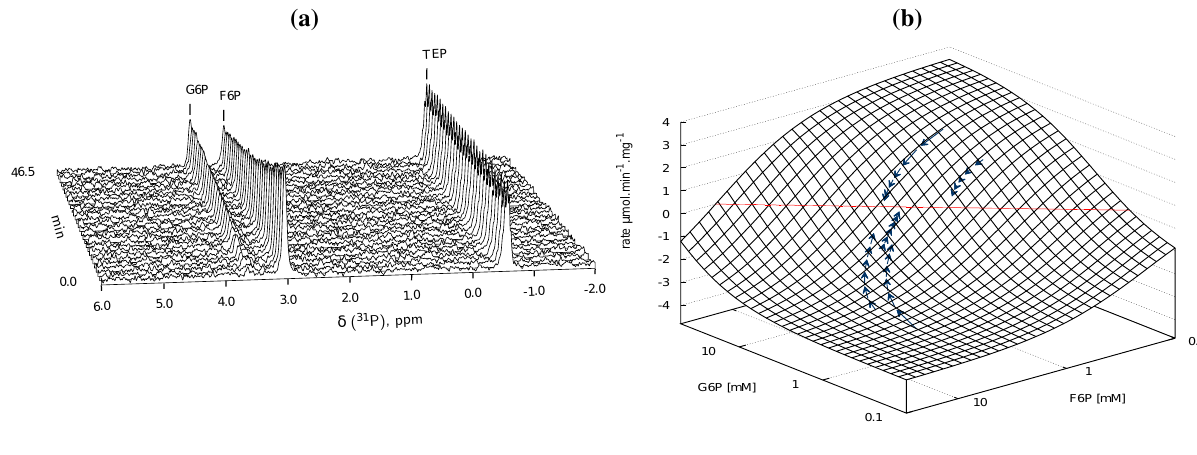
0.28 mM [52], F6P 0.147 mM [52], V aerobic 3.29, 0 . 5 0 . 5 f = 0 . 28 [51]. The higher margin of error on G6P is eq 0 . 5